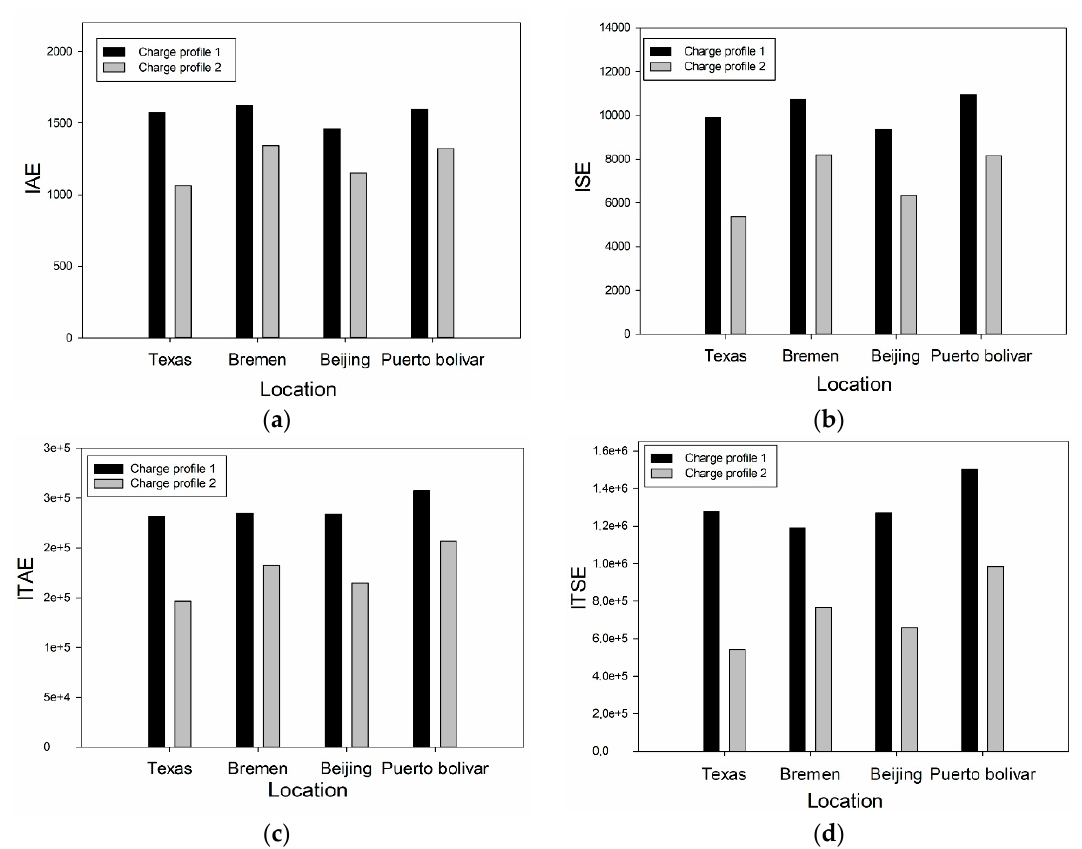
Figure 14. Performance indicators ( a ) absolute value of the error (IAE), ( b ) integral of the square of the error (ISE), ( c ) the integral of the absolute value of the error for time (ITAE), and ( d ) integral of the square of the error for time (ITSE).